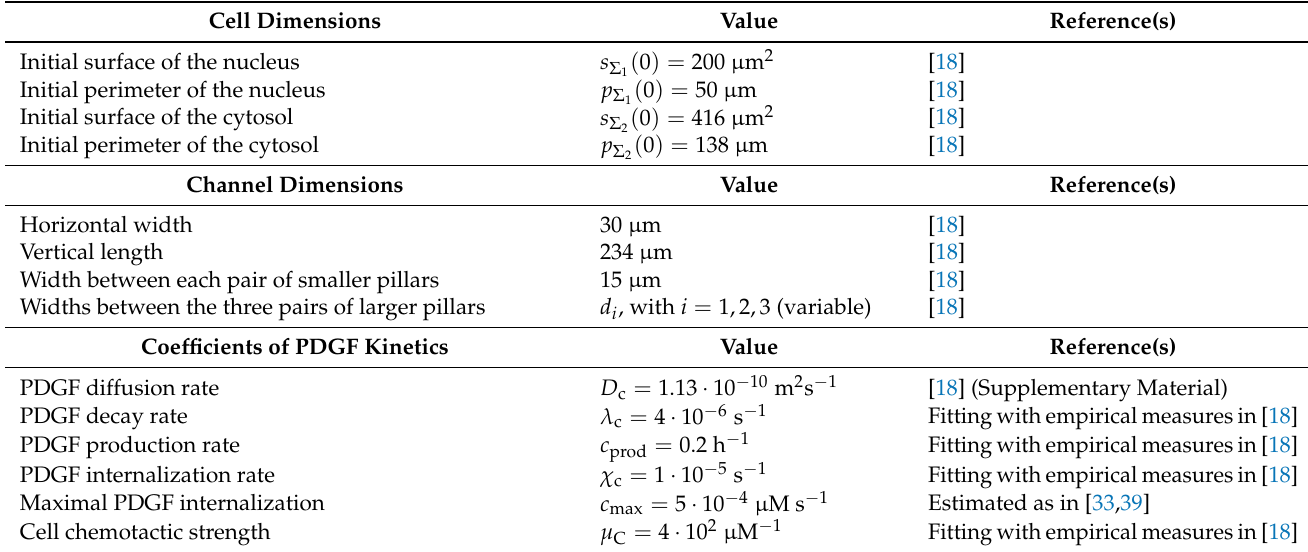
Table 3. Values of the model parameters whose estimates were specifically designed to reproduce the experimental setup used in [18]. They belonged to the set P 1 introduced in Equation